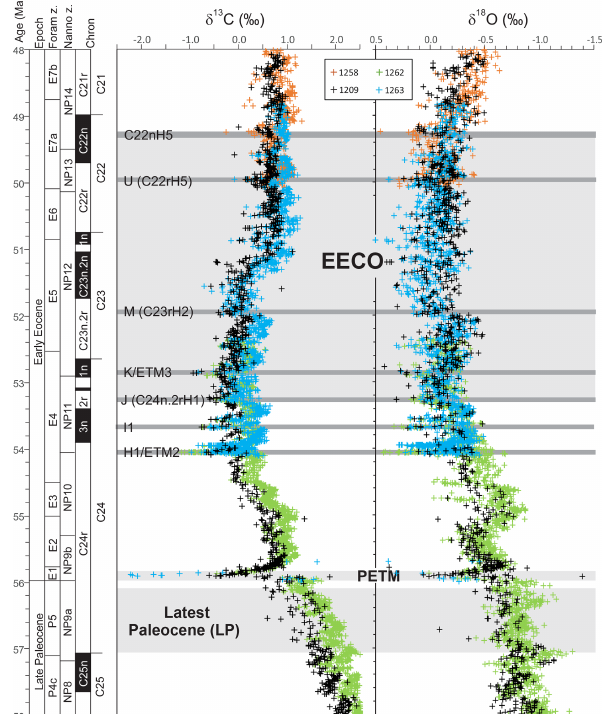
Figure 1. Benthic foraminiferal carbon and oxygen stable isotope records from ODP sites 1209, 1258, 1262 and 1263 (Westerhold et al., 2011, 2017, 2018; Littler et al., 2014; Lauretano et al., 2015, 2018; Barnet et al., 2019) calibrated to the timescale of Westerhold et al. (2017). Calcareous nannofossil and planktic foraminiferal bio- zone boundaries are recalibrated from Gradstein et al. (2012).